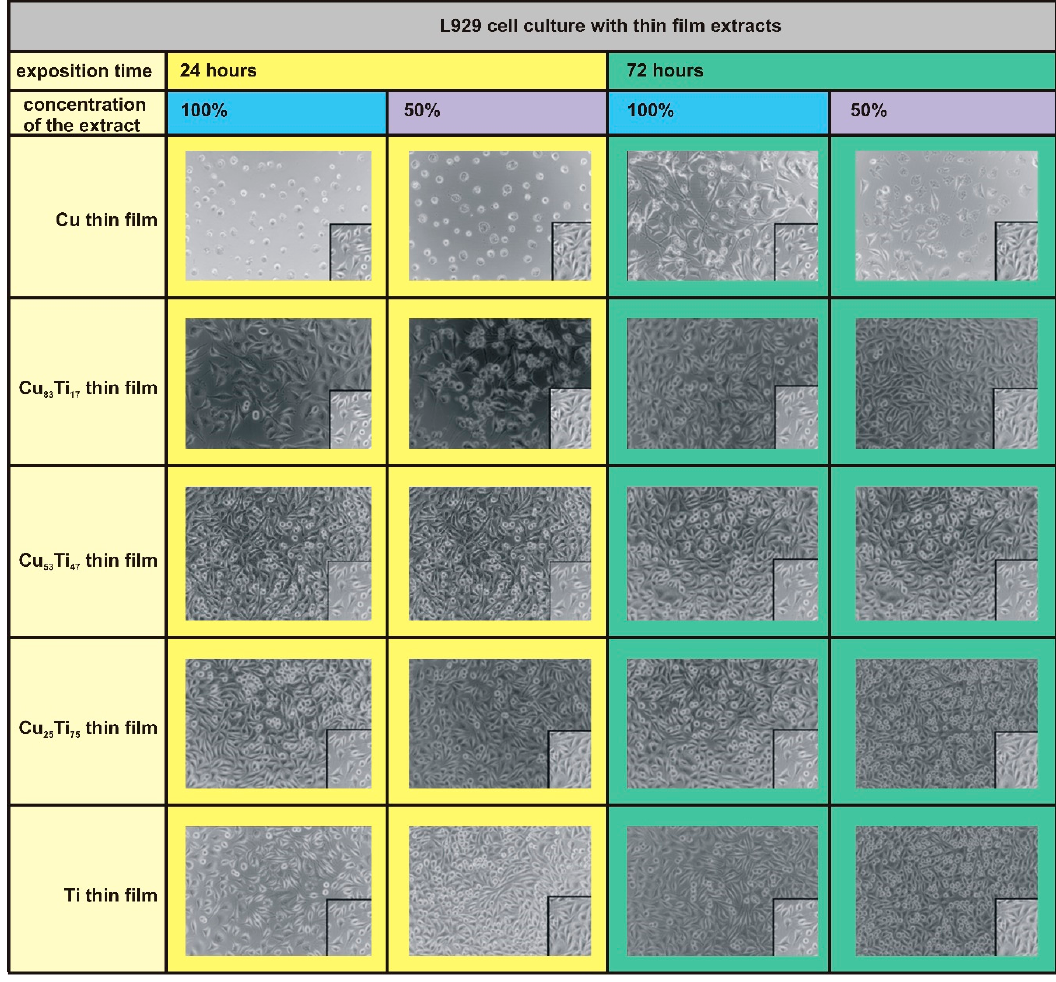
Figure 6. Microscopic photographs of the degree of confluence and changes in the morphology of L929 cells in contact with extracts (in 100% and 50% concentrations) of Cu, Cu-Ti, and Ti thin films after 24 and 72 h of incubation.